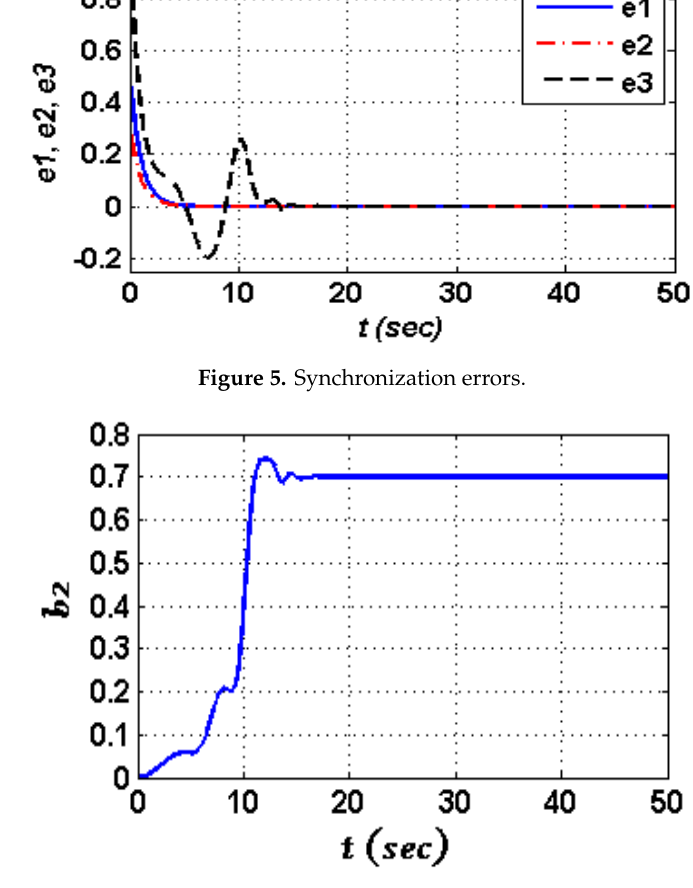
Figure 6 . Estimation of slave parameter b 2 ( t ). Figure 6. Estimation of slave parameter b 2 ( t